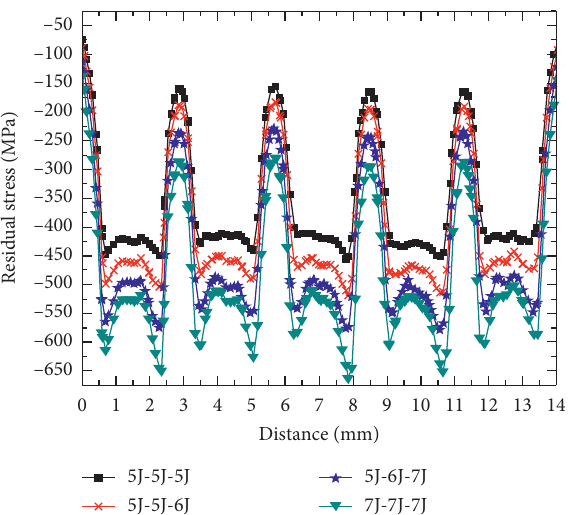
Figure 15: Curves of residual stress distribution of the in-depth direction of sample surface with three different laser